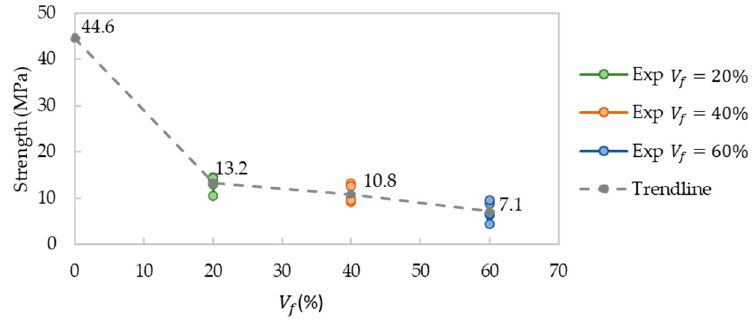
Figure 9. Effective tensile strength of SFRC with load direction of 45 ◦ , depending on volume fraction.